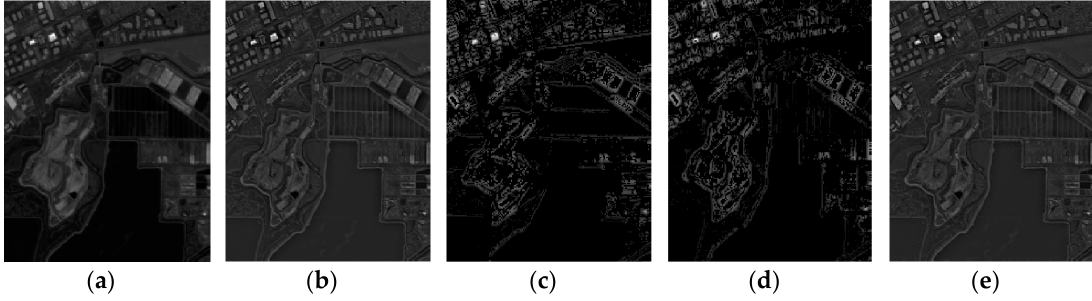
Figure 3. Spatial information of an enhanced PAN image extracted by the gradient methods and the structure tensor method. ( a ) PAN image; ( b ) Enhanced PAN image; ( c ) Horizontal gradient method; ( d ) Vertical gradient method; ( e ) Structure tensor method.